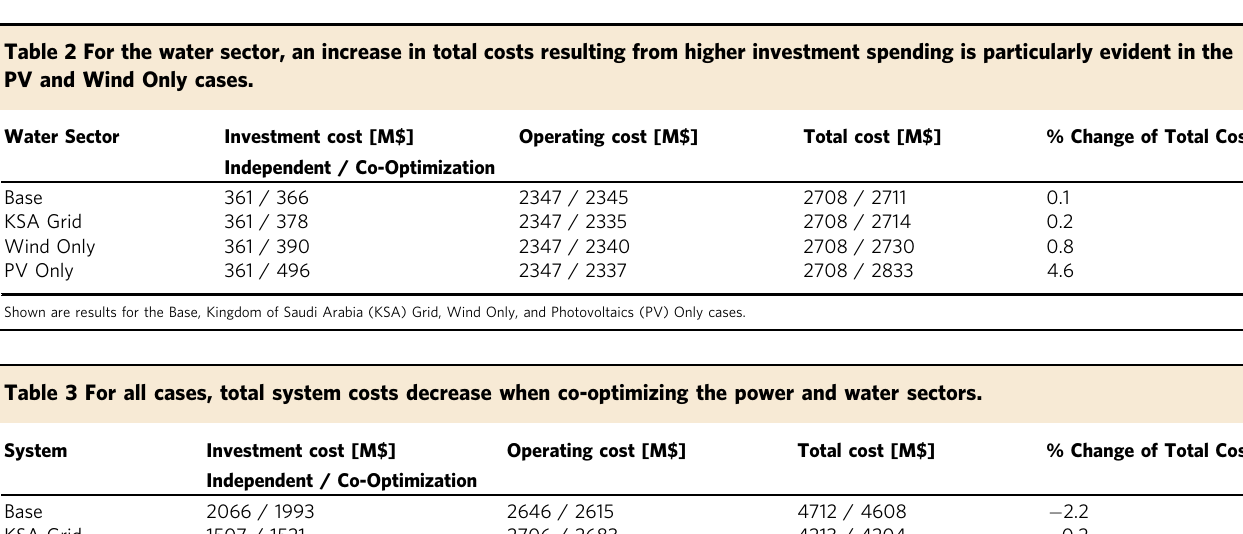
However, systems lacking dispatchable power generators see the most considerable savings. Shown are results for the Base, Kingdom of Saudi Arabia (KSA) Grid, Wind Only, and Photovoltaics (PV) Only cases.